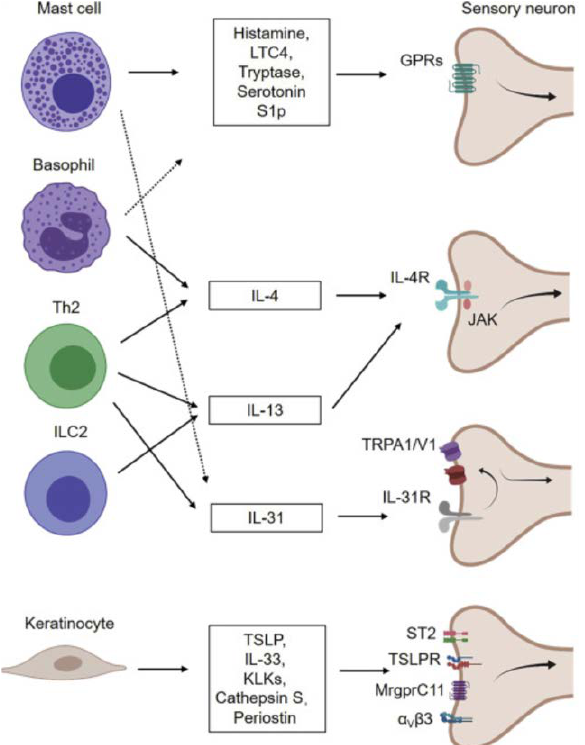
Figure 1. Immune and epithelial cells release cytokines and proteases that can activate itching sensations. Mast cells are a major source of histamine and leukotrienes such as tryptase, and sphingosine-1 phosphate (S1p), which can act directly on sensory neurons via GPCRs. IL-4 and IL-13 directly stimulate sensory neurons and promote itching via IL-4R α -JAK1 signaling on sensory neurons. Both TRPA1 and TRPV1 are involved in the downstream itch pathways mediated by IL-31. The epithelial cytokines thymic stromal lymphopoietin (TSLP) and IL-33, which can also directly stimulate sensory neurons via their receptors TSLPR and ST2, respectively, mediate itch. Dotted arrows indicate limited evidence. (Copyright permission to reproduced this Figure has been obtained from [4])